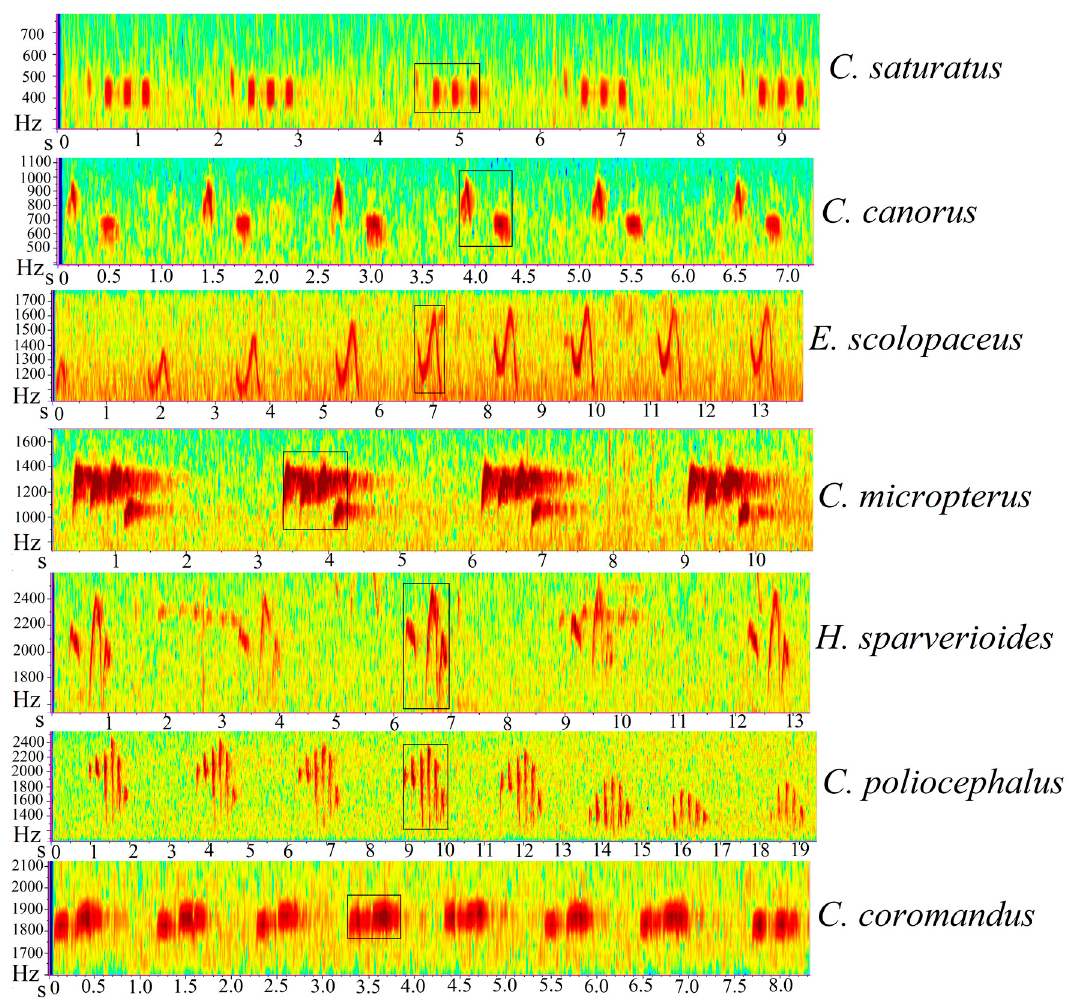
Figure 1. Spectrograms of seven Cuculidae birds from eastern China. The X -axis represents the time in seconds, and the Y -axis represents the frequency in kHz. The sound files can be found in Supplementary Materials and the Spectrograms were made by Raven Pro Version 1.5 software [30]. Examples of calls are shown in black box.